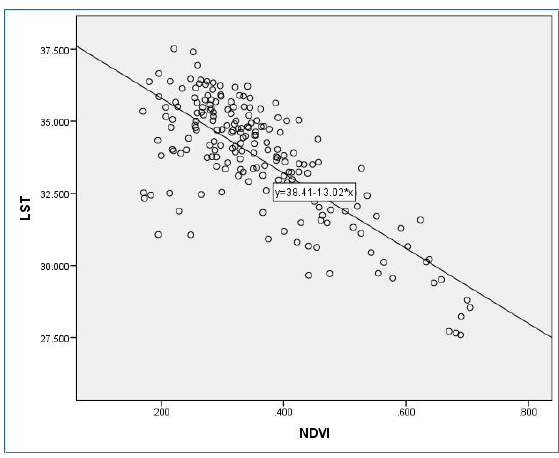
Figure 8. The relationship between LST and green area